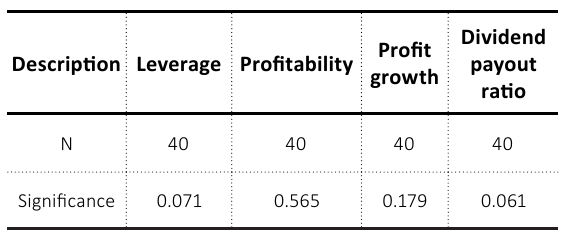
Source: Analysis results.